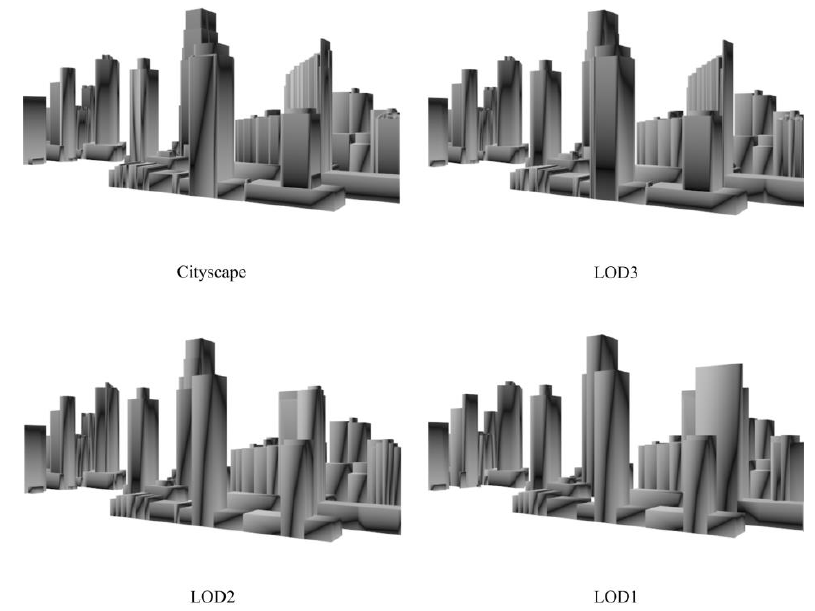
Figure 11. Multi-scale simplification of Cityscape example 1.